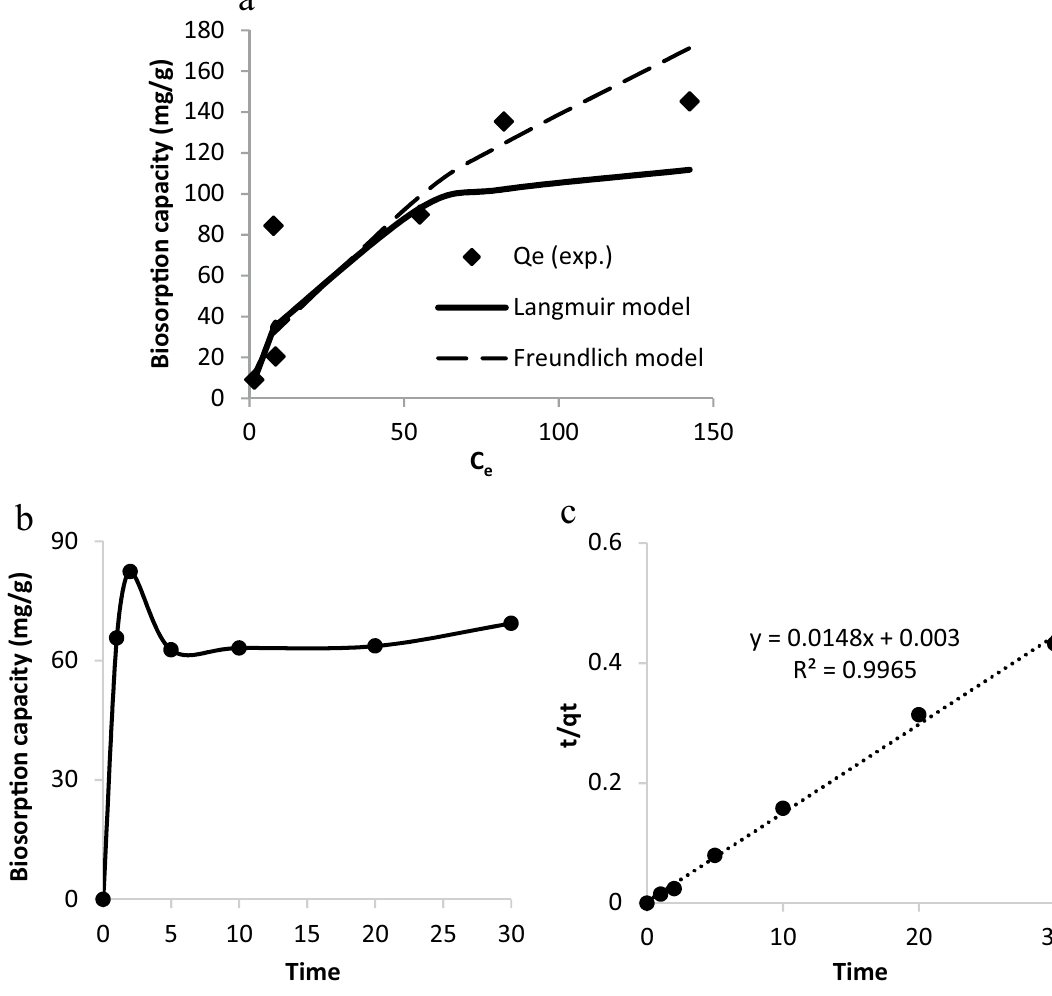
Figure 3. Isotherm and KINETIC studies of Cd ions removal by dry archaeal biomass AB; ( a ) comparison between different isotherm models and experimental data, ( b ) effect of contact time, ( c ) second-order